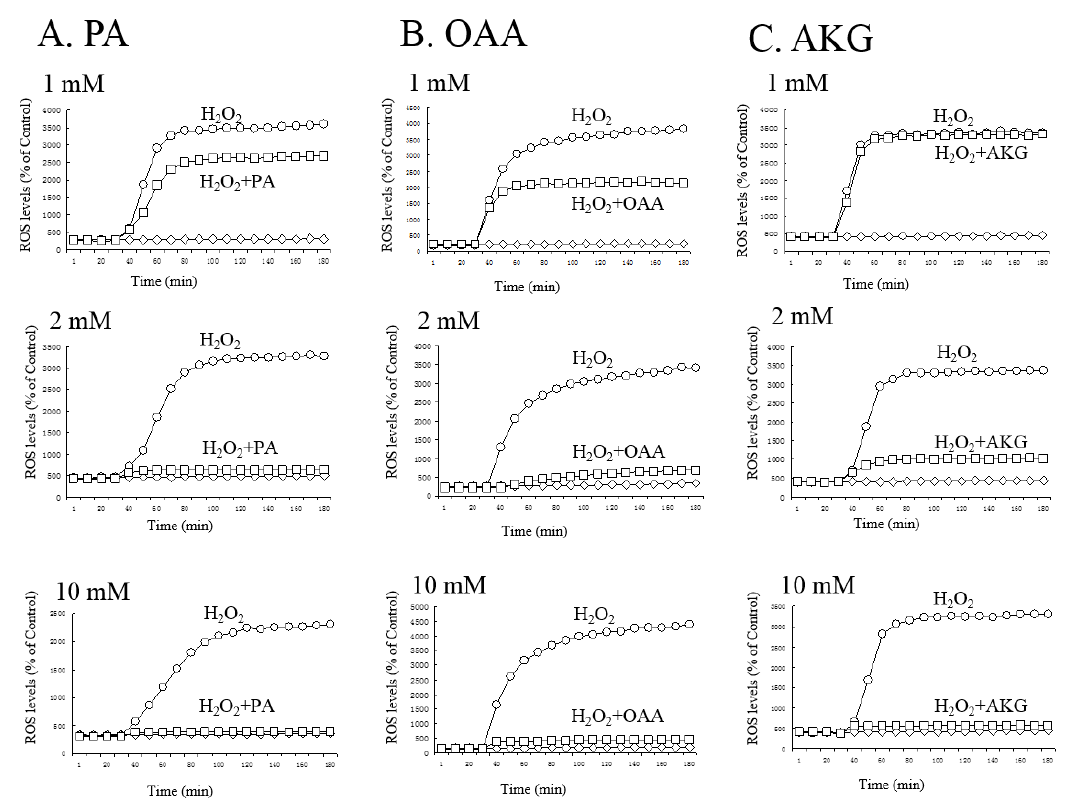
Figure 3. Modulation of reactive oxygen species (ROS) level by ( A ) PA, ( B ) OAA, or ( C ) AKG against H 2 O 2 -induced cytotoxicity. The measurement of the cells loaded with 10 μM DCFH-DA (2′,7′-Dichlorodihydrofluorescin diacetate) for 30 min started at 0 min, and DCF fluorescence levels are shown at 10-min intervals. Various concentrations (1, 2, and 10 mM) of PA, OAA, or AKG were added to the cultures at the same time as DCFH-DA addition. H 2 O 2 (200 μM) was added at 30 min. Values are the means ± SD from four experiments per group. Diamonds, control; circles, H 2 O 2 ; squares, H 2 O 2 + KCI. Note that the KCI alone groups were not shown in these graphs, because KCIs themselves did not affect ROS levels at any time point.